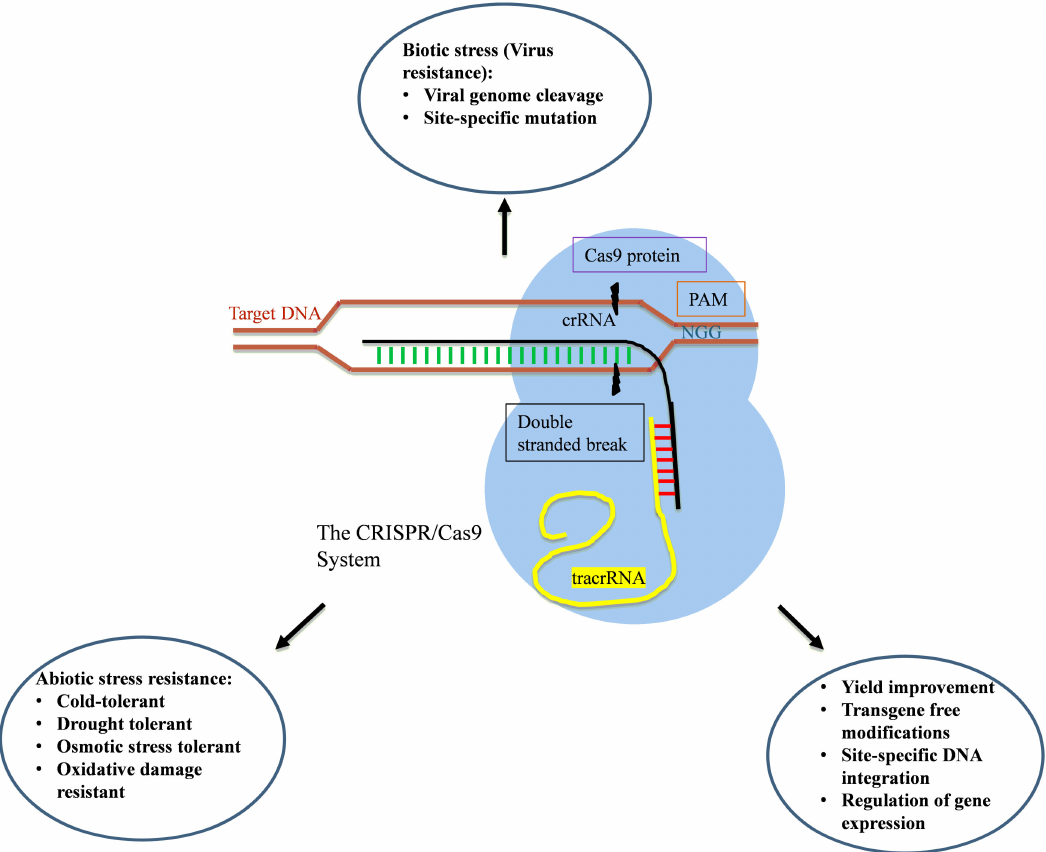
Figure 3. Applications of the CRISPR/Cas9 system in crop improvement. Here, the omission of undesirable traits and the adjunction of purposeful traits occurs through highly specific targeted genome